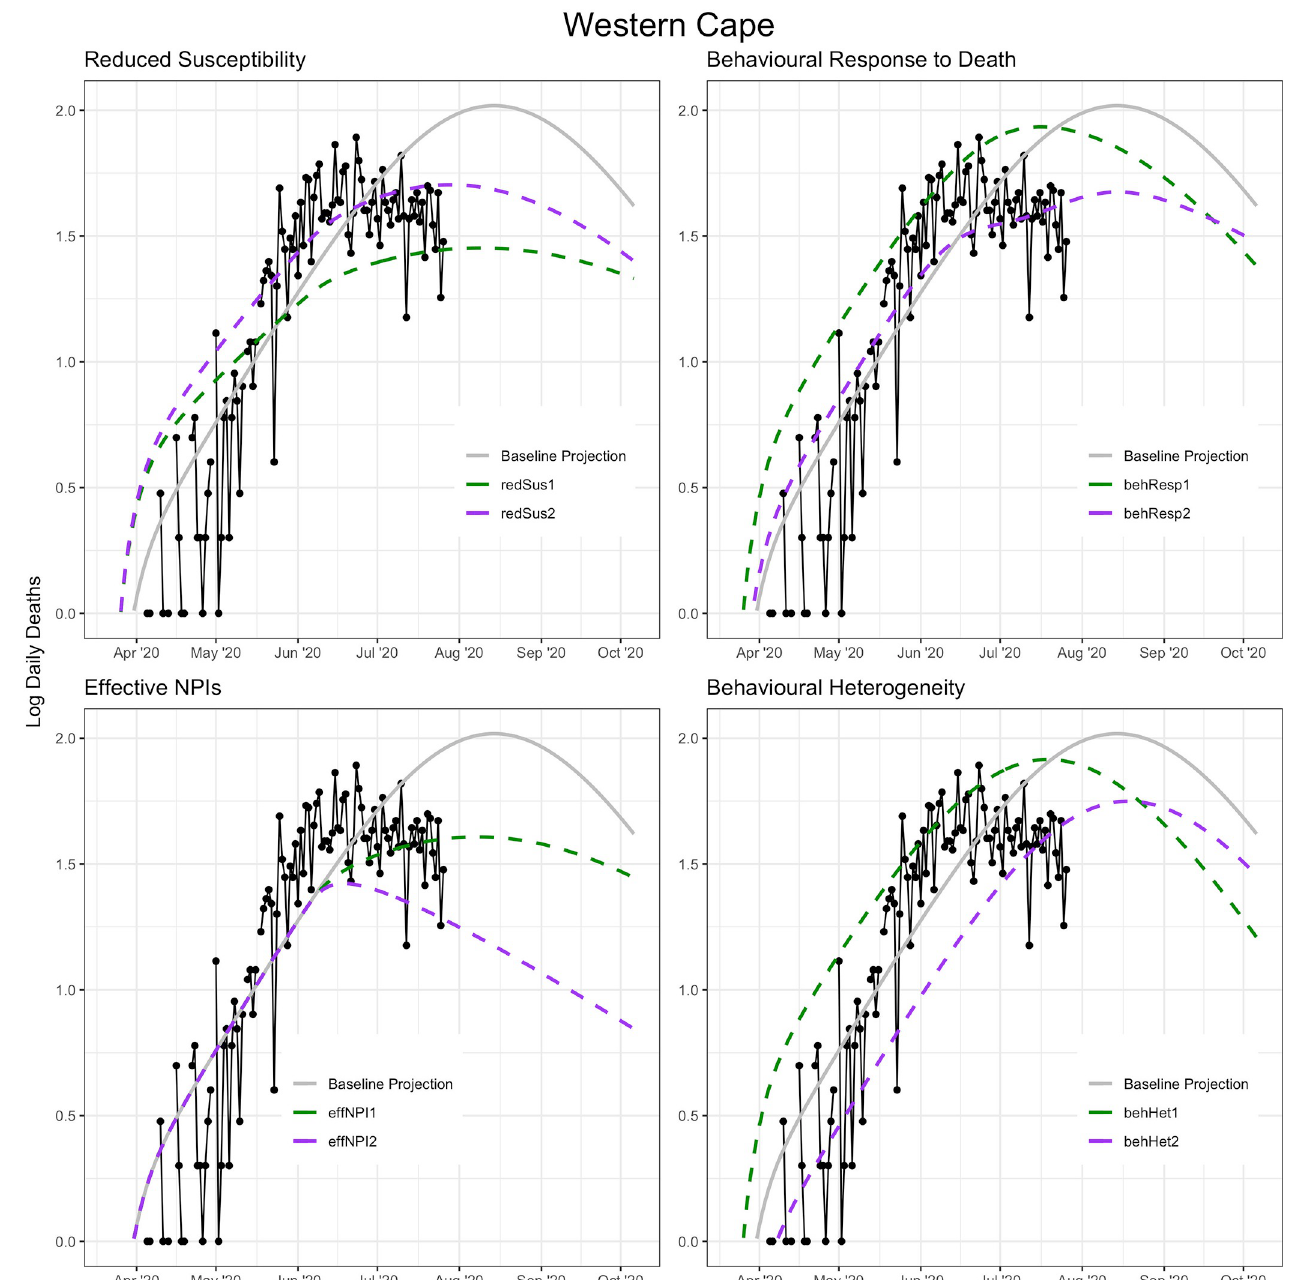
Fig 3. Impact of alternative scenarios on current and projected deaths in the Western